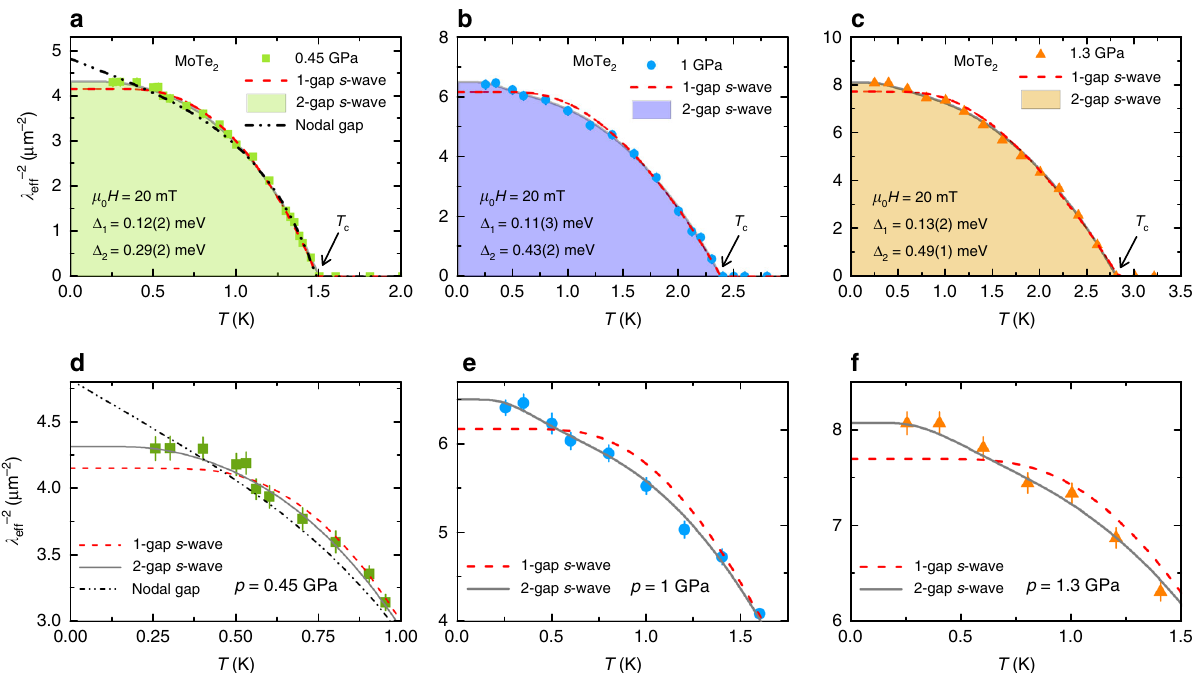
as a function of temperature, measured in an eff